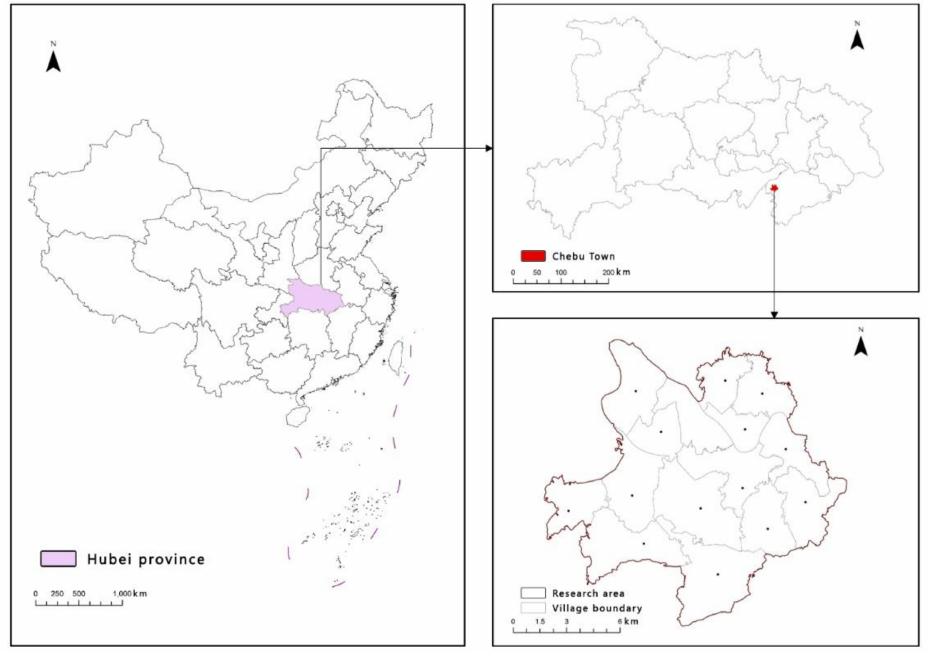
Figure 2. Location of Chebu